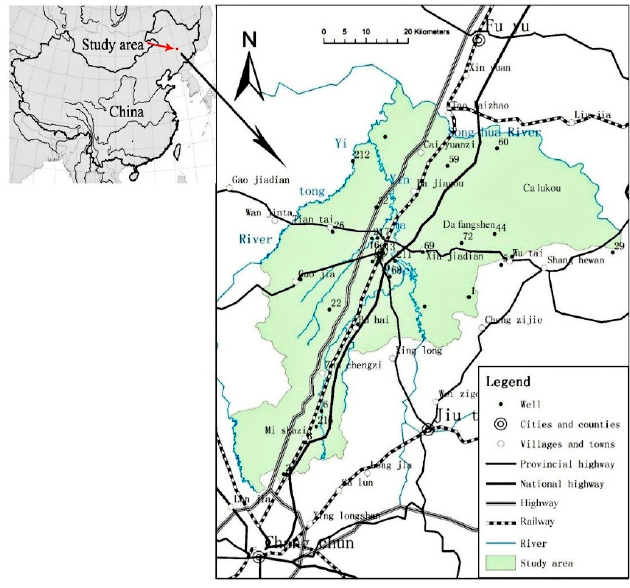
Figure 1. Location map of study area.